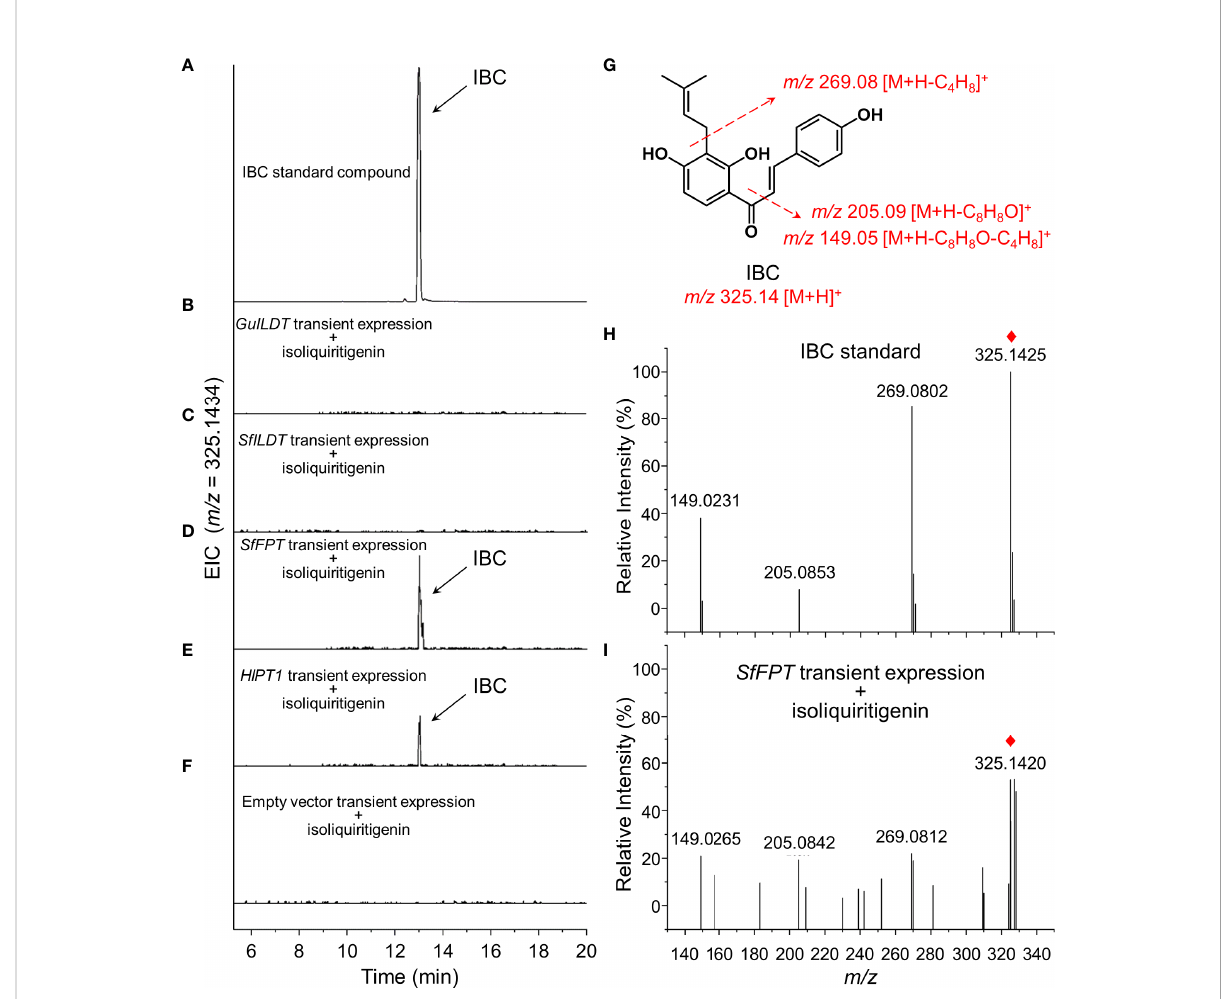
FIGURE 2 Screening of prenyltransferases for the conversion of isoliquiritigenin to isobavachalcone by transient expression. Four prenyltransferases were transiently expressed in tobacco leaves supplied with isoliquiritigenin as the substrate, to validate their in planta activities for the biosynthesis of isobavachalcone (IBC). Representative extracted ion chromatogram (EIC) of (A) IBC standard, (B) GuILDT , (C) SfILDT , (D) SfFPT , (E) HlPT1 expressed samples, and (F) negative control was shown. (G) The structure of IBC and its fragmentation pattern was proposed by dotted arrows. Positive ion modes of MS/MS spectra of (H) IBC standard and (I) SfFPT expressed tobacco leaves was shown. Red rhombs indicated the precursor ions of